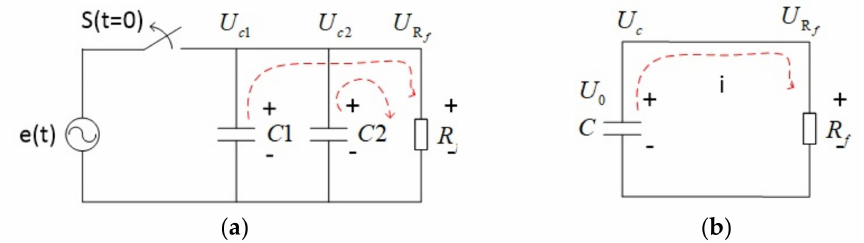
Figure 10. The first-order discharge circuit composed of feedback resistors and integral capacitors: ( a ) zero input response of RC Circuit; ( b ) first-order RC discharge equivalent